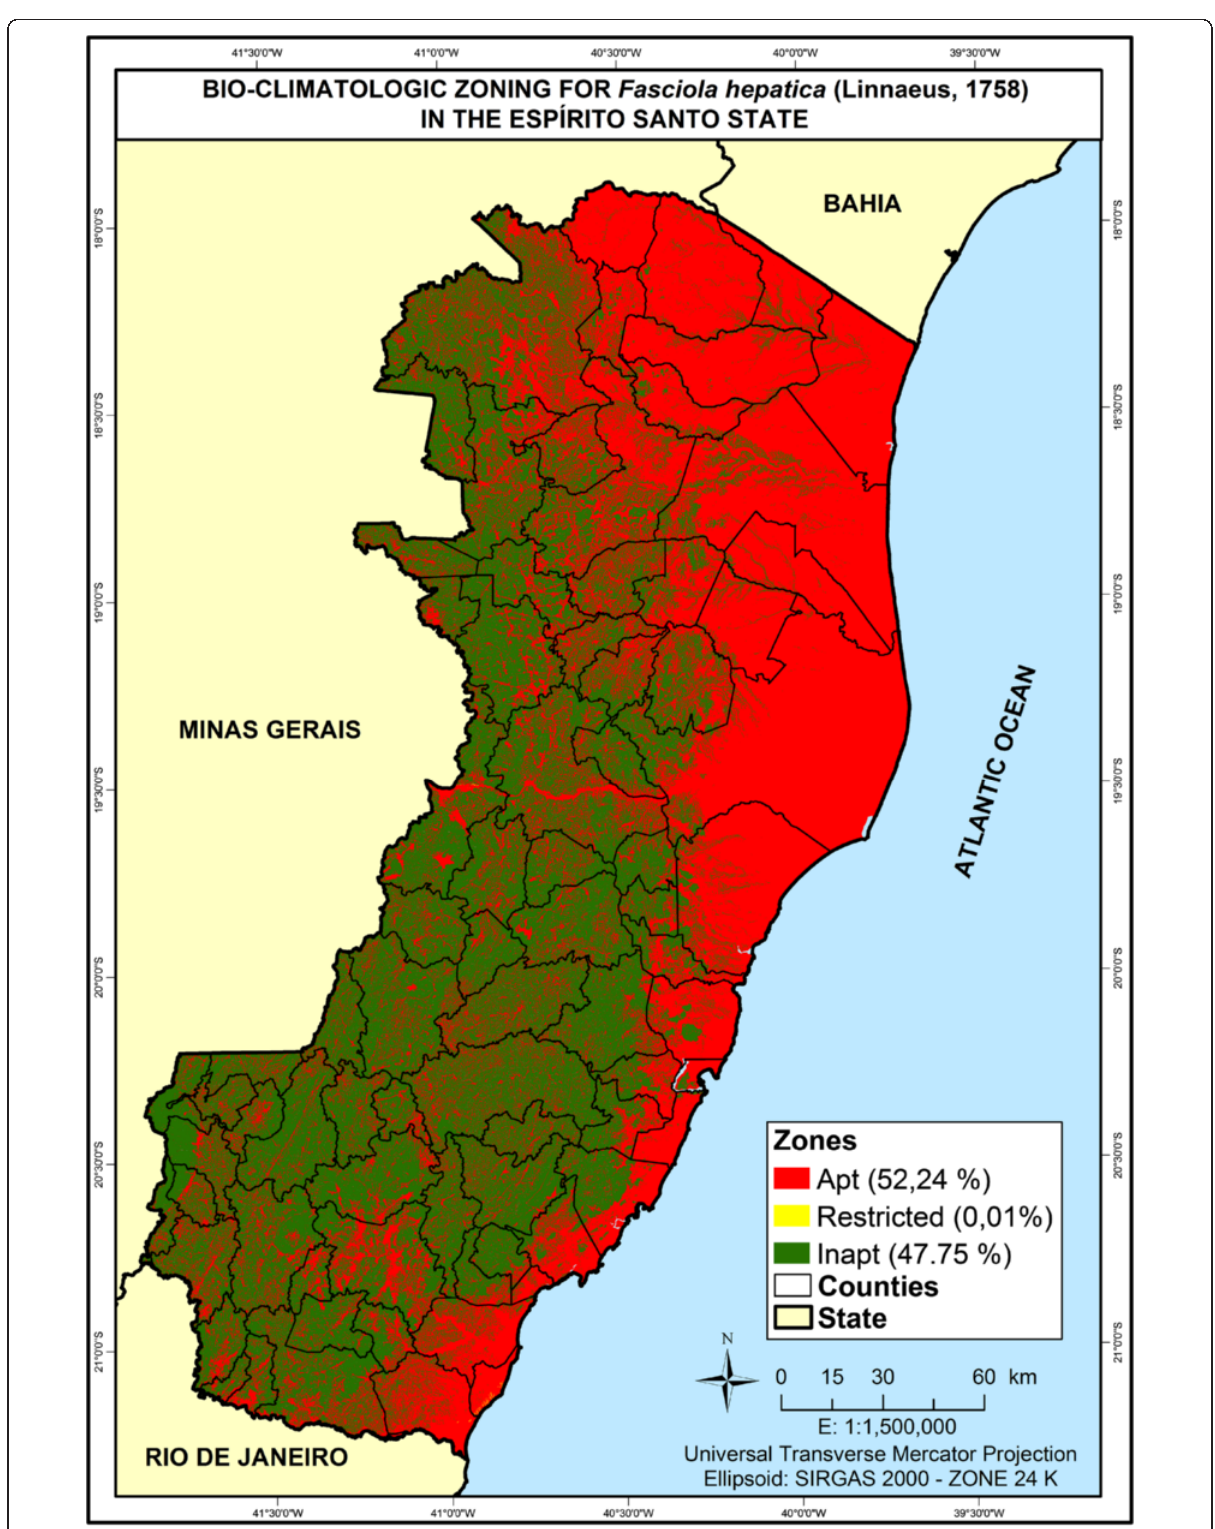
Figure 2 Bioclimatic distribution of F . hepatica in Espírito Santo and suitability for its development in the